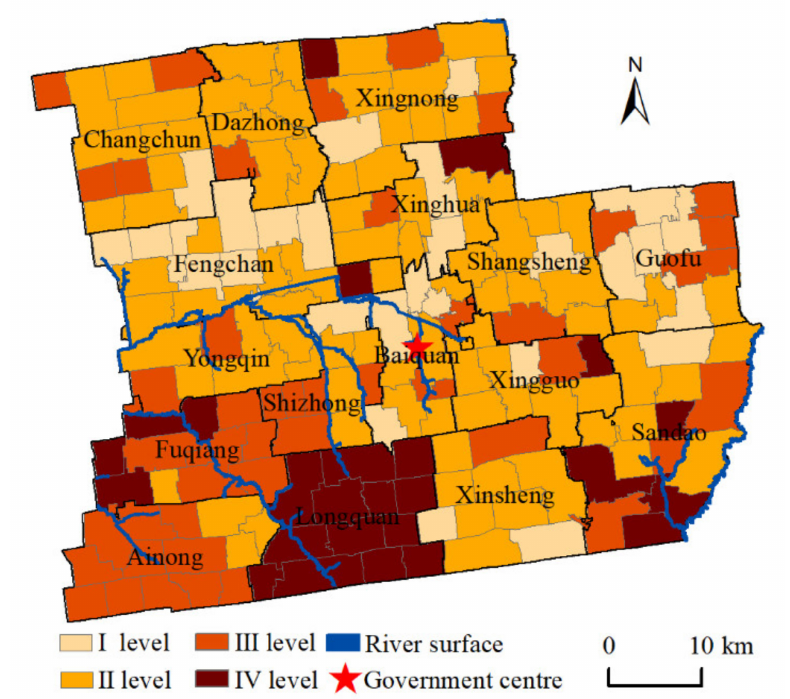
Figure 5. Distribution of the input intensities of the cultivated land use.